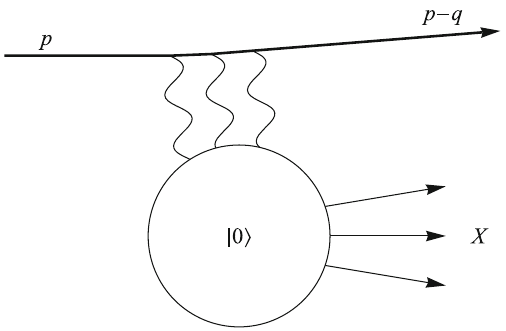
Fig. 3 Schematic illustration of inclusive scattering of a fast charged particle on an atom in initial state | 0 (cid:11) . Due to the large Coulomb param- eter, the particle–atom interaction is nonperturbative, i.e., multiple pho- ton exchanges can contribute significantly. After the scattering, the fast particle is imparted a momentum − q , while its energy changes rela- tively slightly. The excited atom goes to an arbitrary state with total momentum q . Such states are collectively designated as X . The process differential cross section is summed over all of